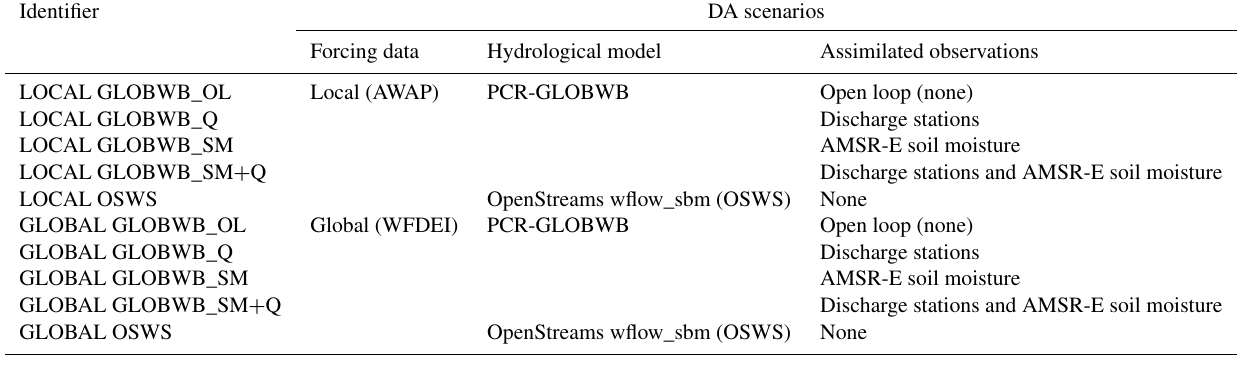
Table 4. Data assimilation scenarios including abbreviations, forcing data, hydrological model and assimilated observations.